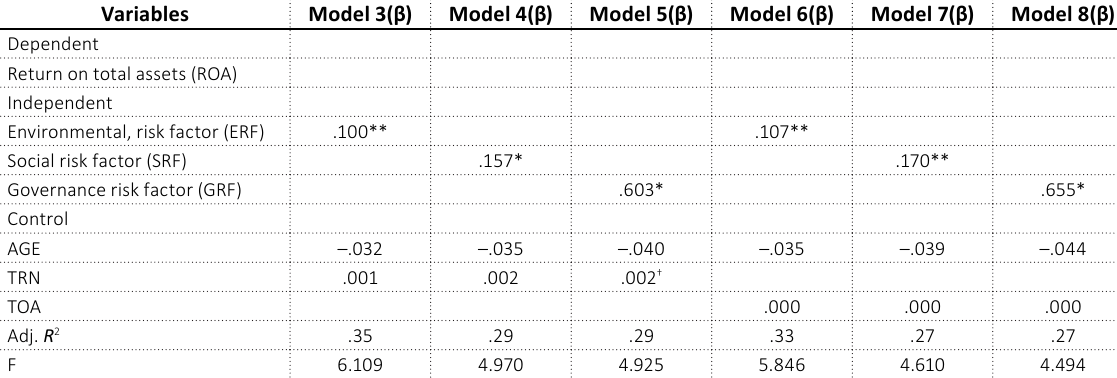
Table 7. Results of regression analysis for environmental, social, and governance scores as independent variables controlled for size (2012)